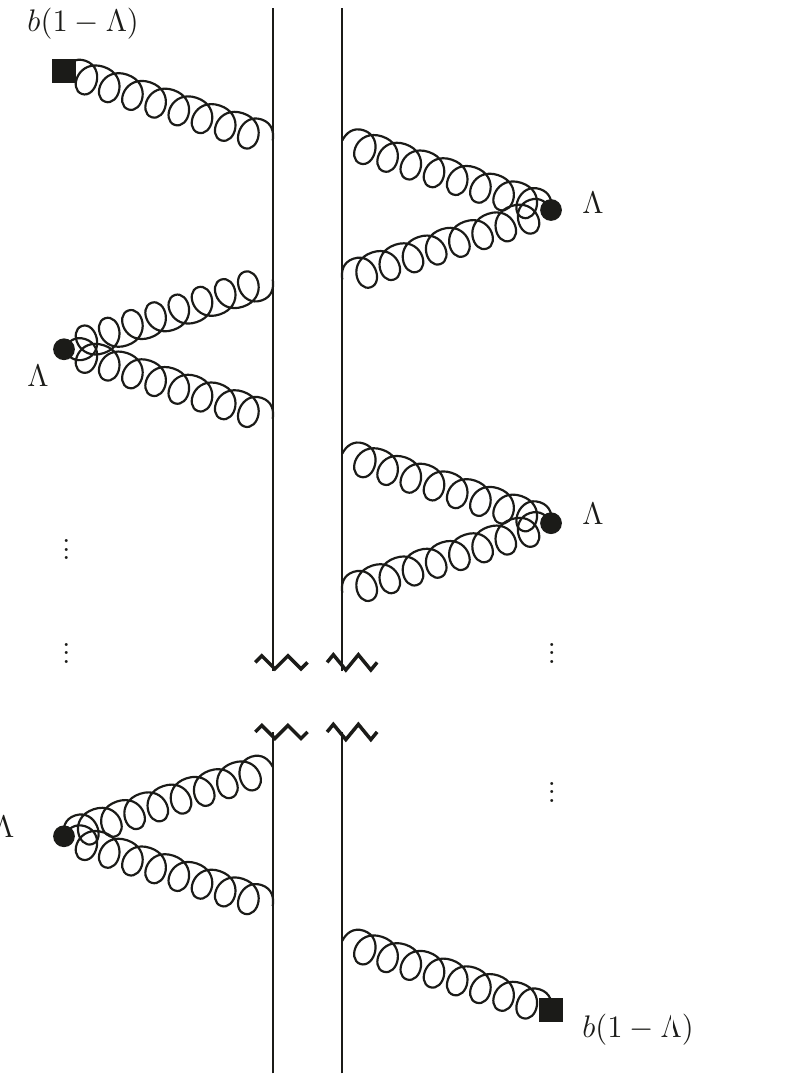
Figure 1 . The diagrams involving the odd number of gluons that contribute terms linear in (cid:1) y to the evolution of ^ (cid:26)